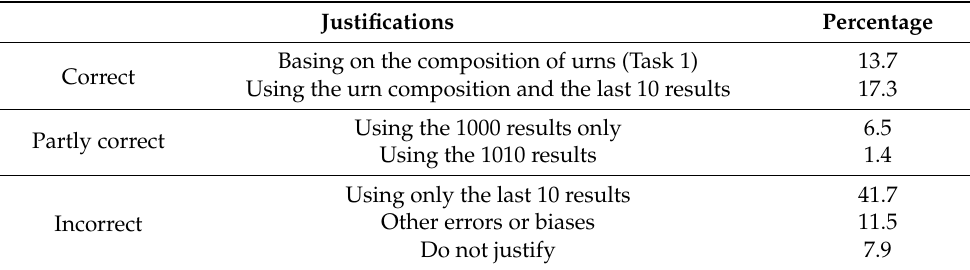
Table 5. Justifications of responses given to Task